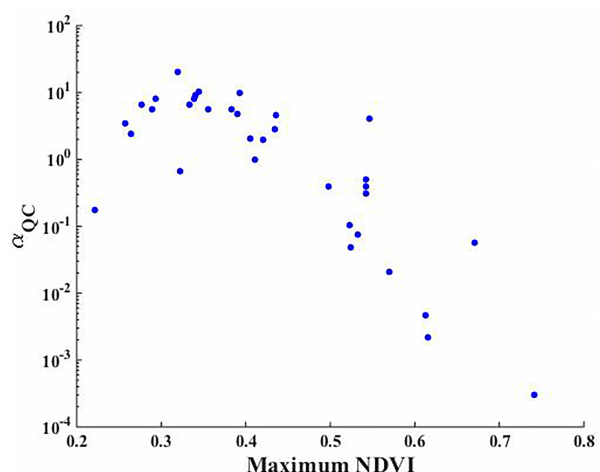
Figure 2. Scatter plots between the maximum NDVI and slope in the Q – C regression at an annual scale ( α QC ) from the 44 study